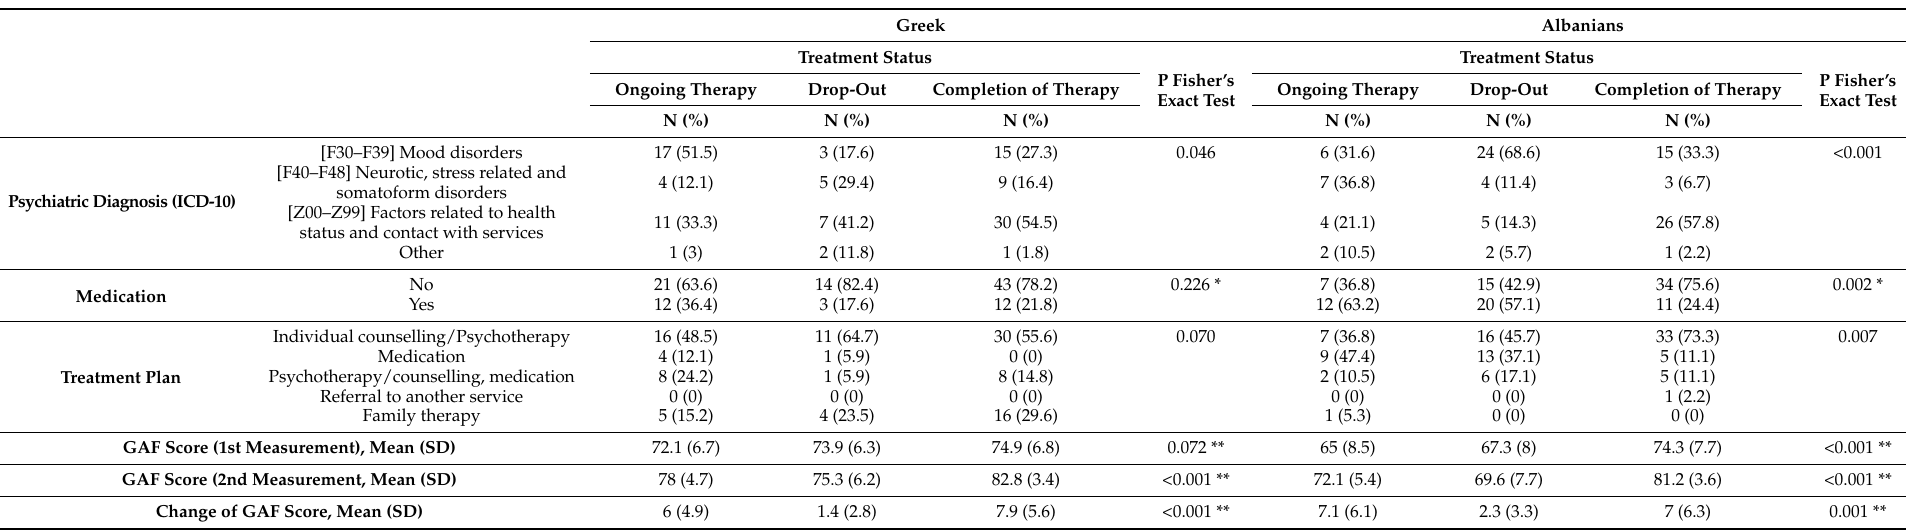
Table 7. Correlation of treatment status with diagnosis, medication, treatment plan and GAF